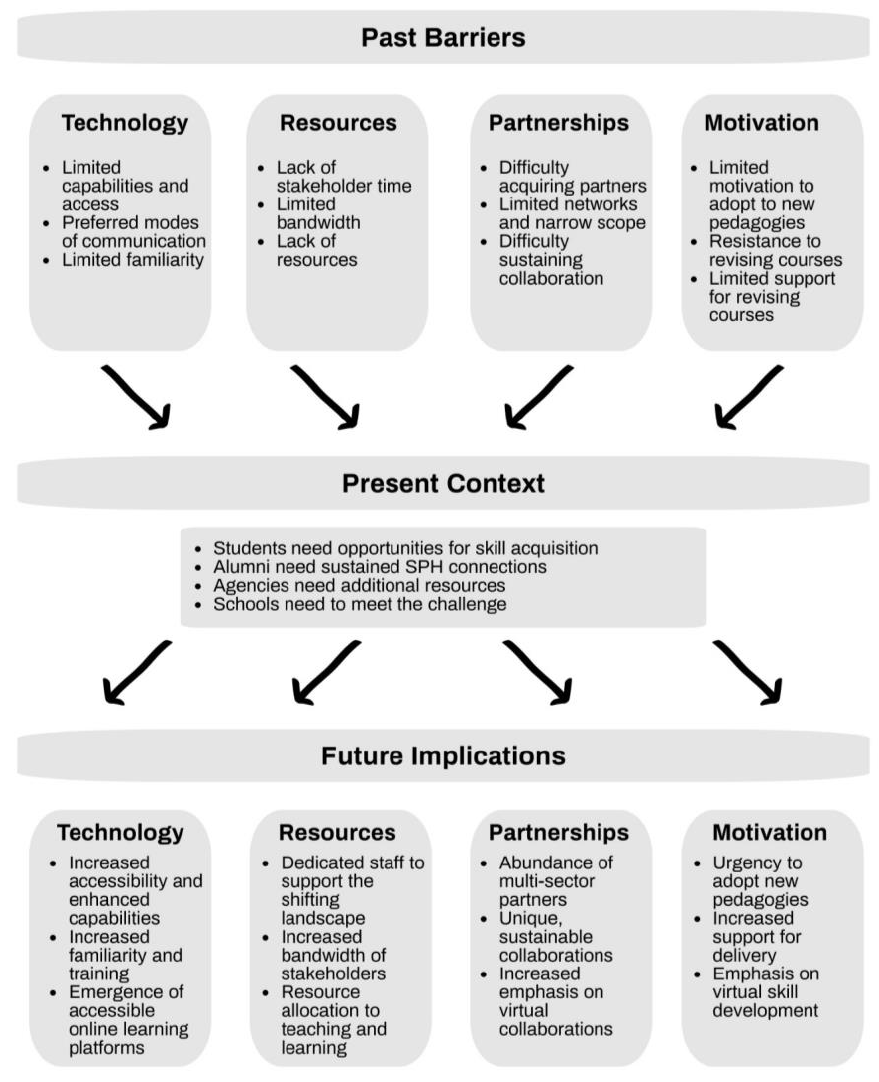
Figure 1. Factors for Virtual, Scalable, and Sustainable Practice-Based Teaching.